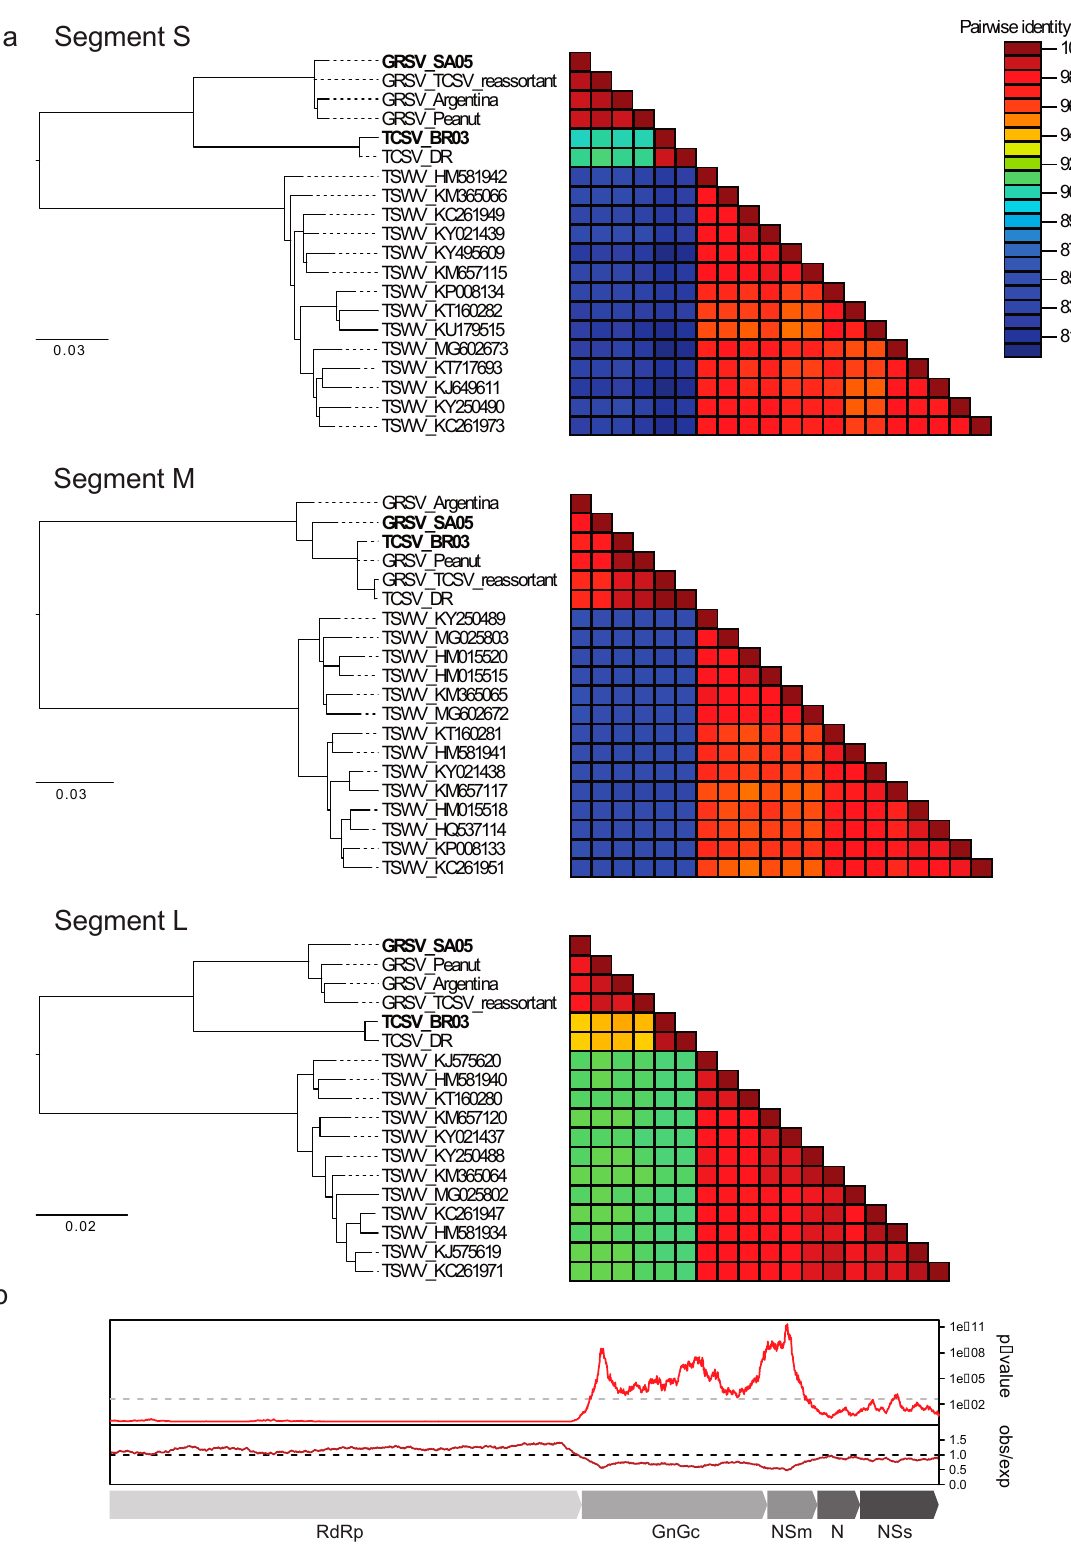
Figure 3. Phylogenetic trees based on concatenated protein sequences encoded in the S, M, and L RNAs of TCSV, GRSV, and TSWV isolates, and the observed/expected synonymous mutations in the coding regions of TCSV and GRSV isolates. ( a ) Maximum likelihood trees and protein identity plots of the S, M, and L segments of TCSV, GRSV, and TSWV and ( b ) suppression of synonymous mutation variability in the concatenated ORFs of TCSV and GRSV using a sliding window of 250